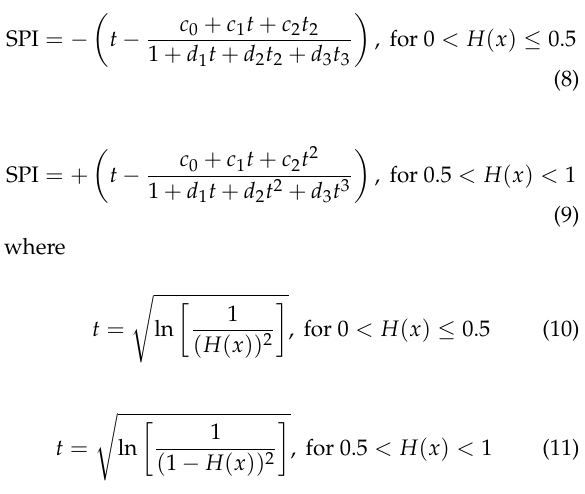
standardized distribution with null average and unit